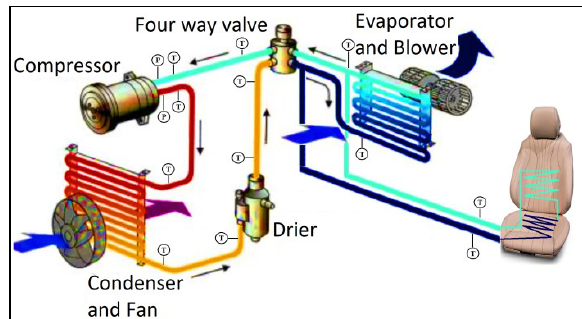
Fig. 2. Schematic air conditioner system